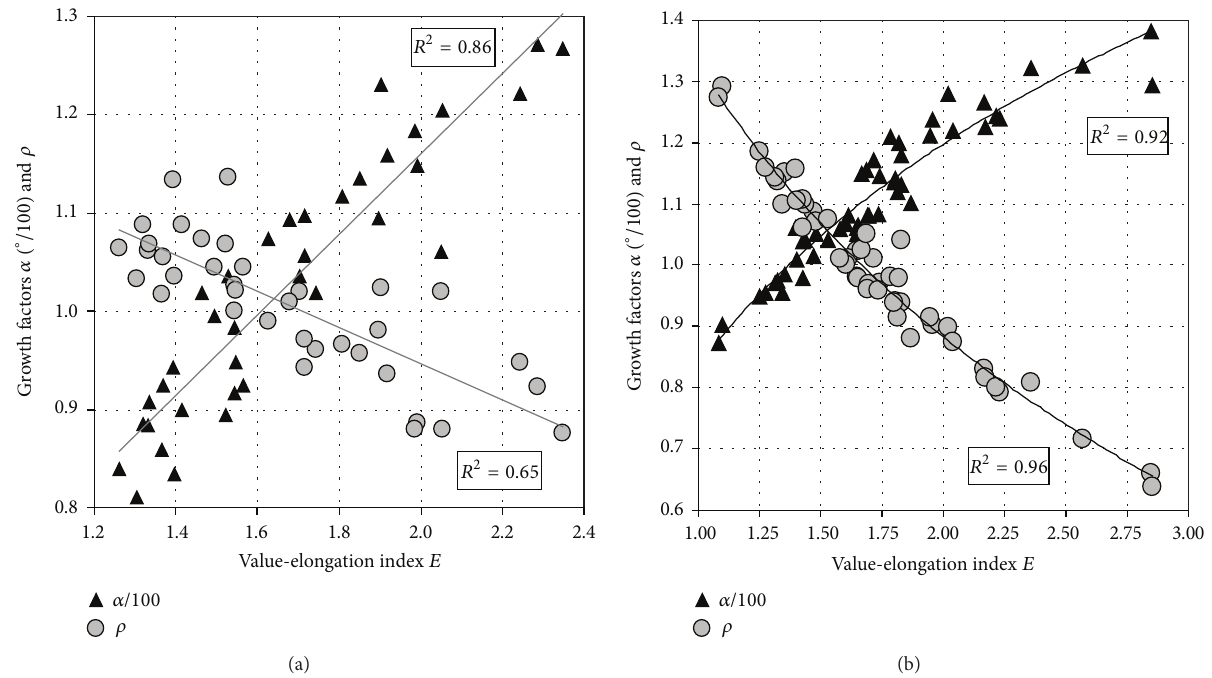
Figure4:Theshellelongation E plottedagainstthegrowth-basedparameters 𝛼 and 𝜌 ,for36specieswithinthegenus Donax (a)and49species within the genus Tellina (b)— black triangles : apical angle 𝛼 ( ∘ /100); grey dots : differential growth index 𝜌 . The increase of 𝛼 and decrease of 𝜌 with growing E are both highly significant for both genera ( 𝑃 < 0.0001 in all cases).